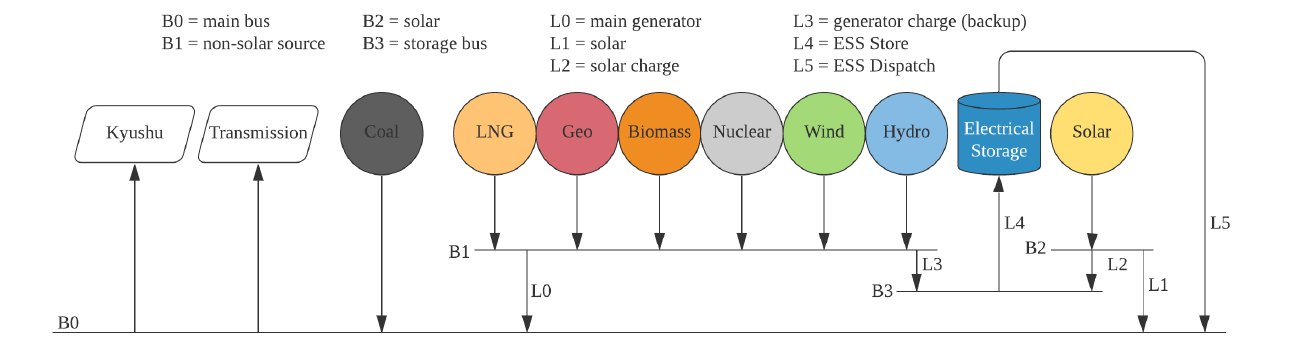
Figure 5. Configuration of the grid used in the